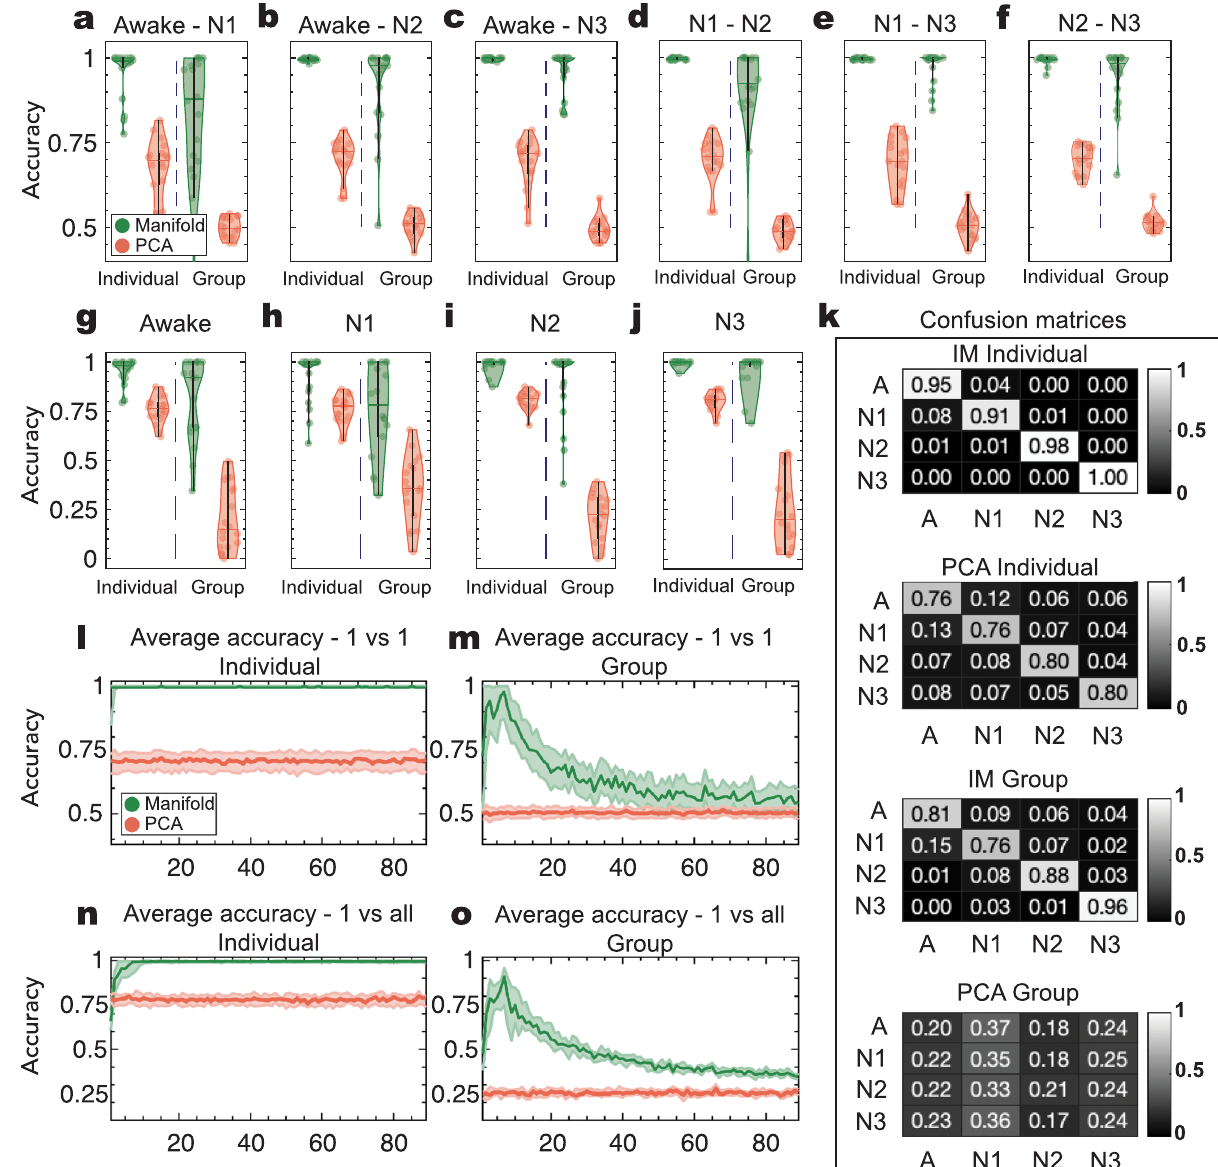
Fig. 3 Accuracy of brain state decoding on the intrinsic manifold of brain dynamics and on PCA. Decoding accuracies in the feature space de fi ned by the intrinsic manifold (IM) and PCA space for different experiments. a – f The accuracies of the SVM 1-vs-1 classi fi cation between a wakefulness and N1, b wakefulness and N2, c wakefulness and N3, d N1 and N2, e N1 and N3, and f N2 and N3. g – j The accuracies of the SVM 1-vs-all classi fi cation for each stage: g wakefulness, h N1, i N2 and j N3. The accuracy is de fi ned as the ratio between the number of true positives and the total number of tested time points. The boxplots ’ centrality is indicated by the median, and the boxes extend between 25th and 75th percentiles. Each colored circle corresponds to the classi fi cation accuracy for each single subject (in the case of individual analysis, left of the dashed line) and to the accuracy of each leave-one-subject-out round (in the case of group analysis, right to the dashed line). The classi fi cation accuracies on the intrinsic manifold and in PCA space are represented by green and red dots, respectively. Classi fi cations are performed in spaces of dimensionality d = 7 (see Supplementary Fig. 3 for d = 3). For all classi fi cations, intrinsic manifold classi fi cation yields signi fi cantly higher accuracies (for all comparisons, p -value < 0.001, Wilcoxon Rank-sum two-sided test, corrected for multiple comparisons via FDR). k Confusion matrices obtained from the 1-vs-all classi fi cation experiments (shown in g – j . l , m show the average accuracy across all stage-to-stage (1-vs-1) classi fi cations for varying dimensionality of the embedding spaces for individual participants ( l ) and for group analysis ( m ), respectively. n , o show the average accuracy for all stages (1-vs-all) classi fi cations for varying dimensionality of the embedding spaces for individual participants ( n ) and for group analysis ( o ), respectively. The solid lines indicate the median of the distribution across classi fi cations and shaded areas indicate 25th and 75th